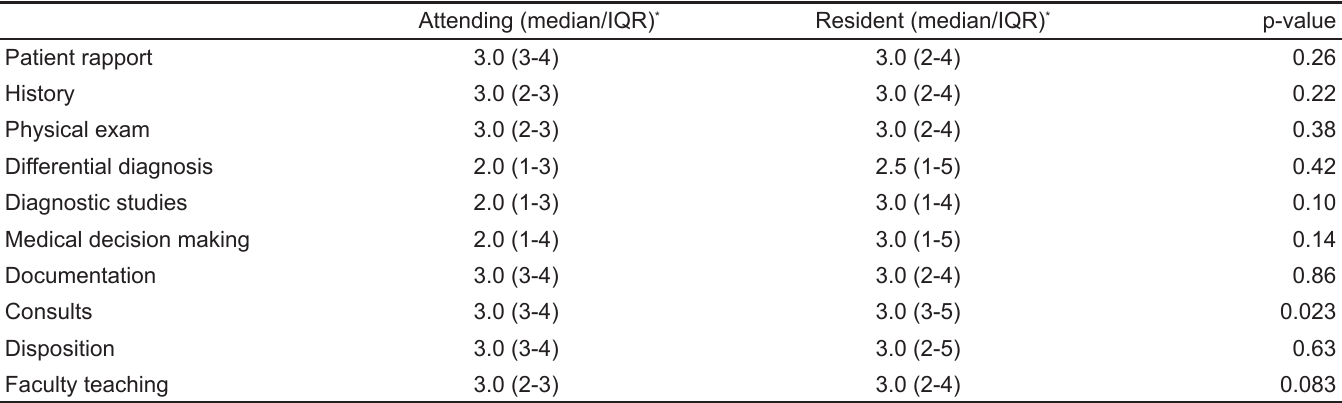
Table 3 . Attending and resident perceived impact of physician in triage on patient rapport, history taking, physical exam, differential diagnosis, diagnostic ordering, medical decision making, documentation, consultation, disposition, and faculty teaching.